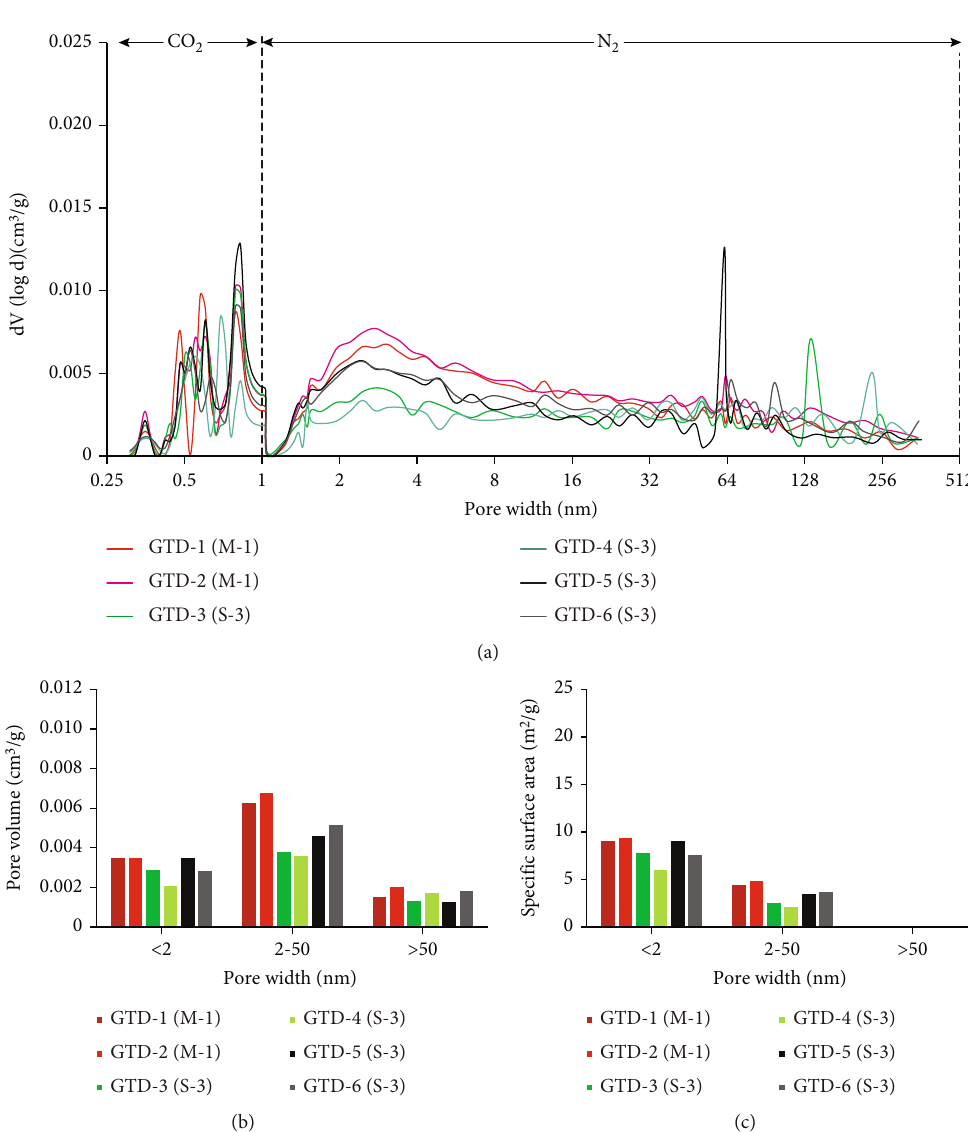
Figure 8: (a) N and CO pore diameter adsorption curve of Devonian shale samples in well GTD1; (b) pore volume distribution of 2 2 Devonian shale samples in well GTD1; (c) pore speci fi c surface area of Devonian shale samples in well